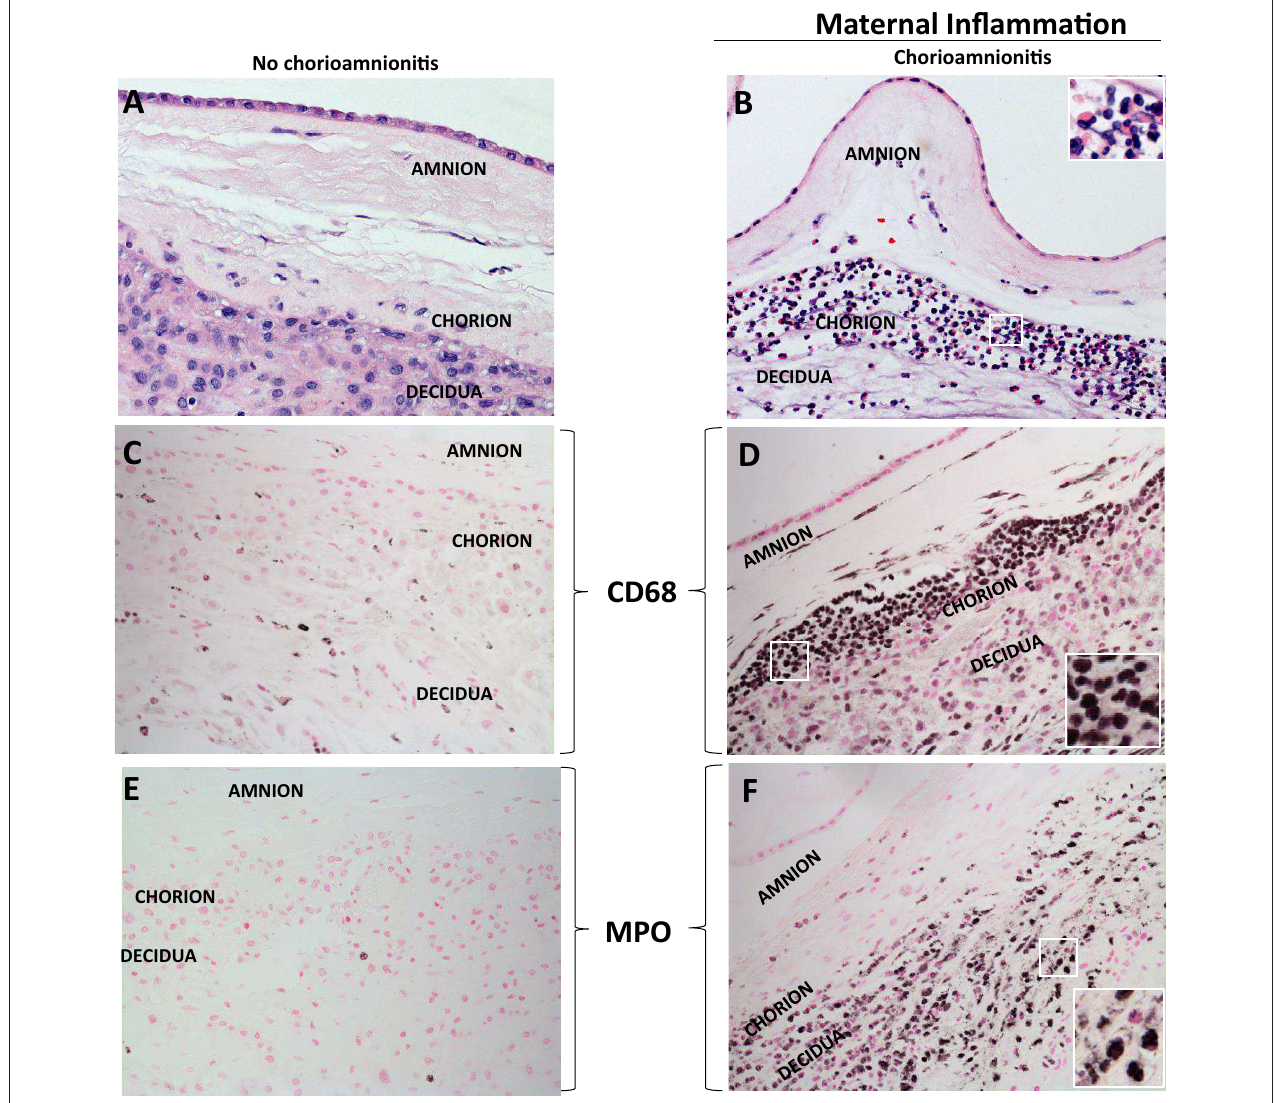
FIGURE 1 | H&E histology of intrauterine inflammations. (A,B) Cross sections of human fetal membranes H&E histology showing neutrophil infiltration. Chorioamnionitis is characterized by infiltration of (D) CD68 + macrophages and (F) neutrophils expressing Myeloperoxidase + (MPO) predominantly located at the choriodecidua junction. Note relatively much fewer CD68 or MPO expressing cells in the no chorioamnionitis group (C,E) . Insets in (B,D,F) show higher power magnification of demarcated area in white and demonstrate inflammatory cells including neutrophils and